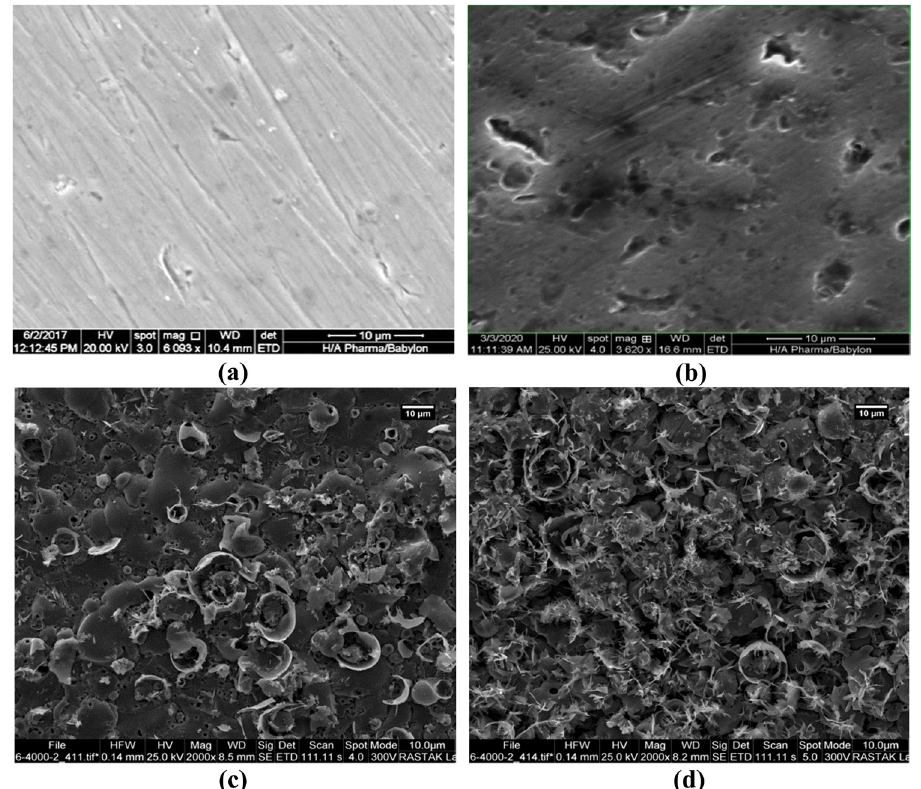
Figure 3: SEM morphology topographic for coating layers at magni fi cation ( 2,500 × ) : ( a ) SS, ( b ) Ni – Pb, ( c ) Ni – Pb – 10ZrO 2 , ( d ) Ni – Pb – 20ZrO 2